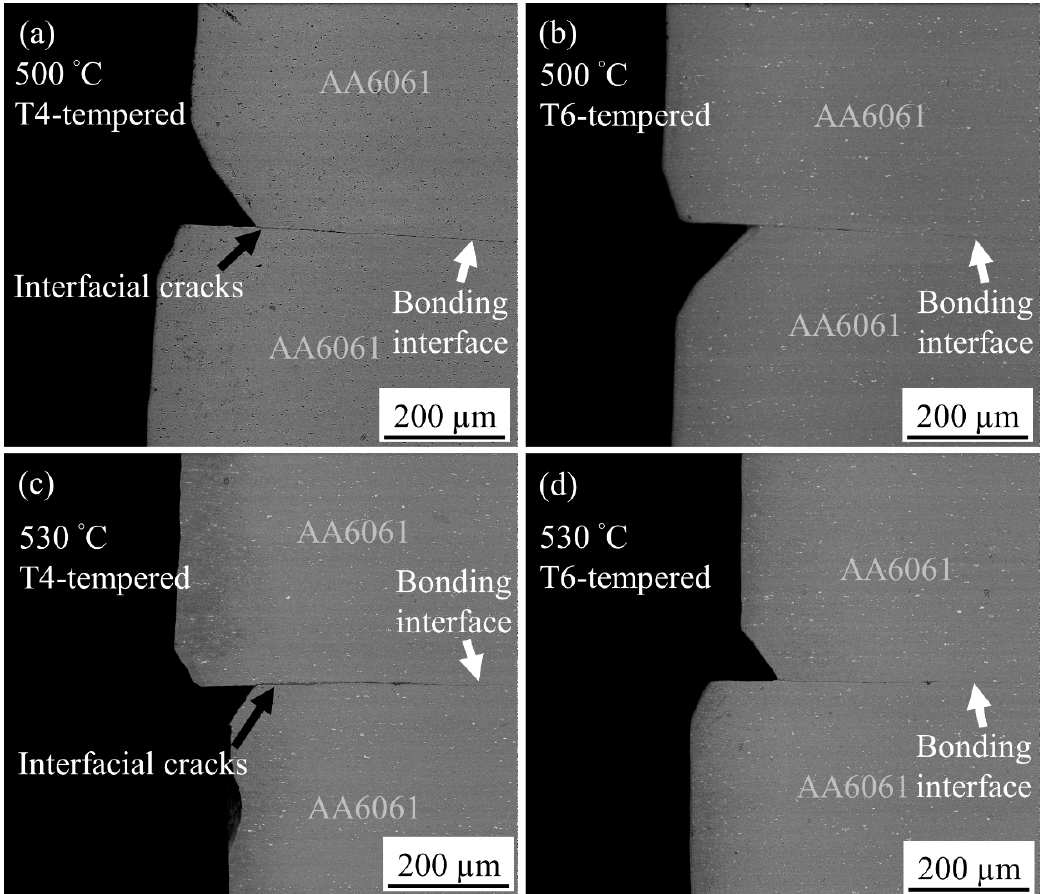
Figure 8. Microstructure of AA6061/AA6061 bonding interface after diffusion bonding at ( a ) 500 °C with T4-PWHT ( b ) 500 °C with T6-PWHT, ( c ) 530 °C with T4-PWHT, and ( d ) 530 °C with T6-PWHT.